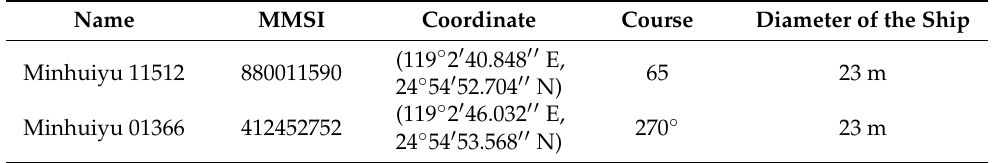
Table 5. Simulation of ship